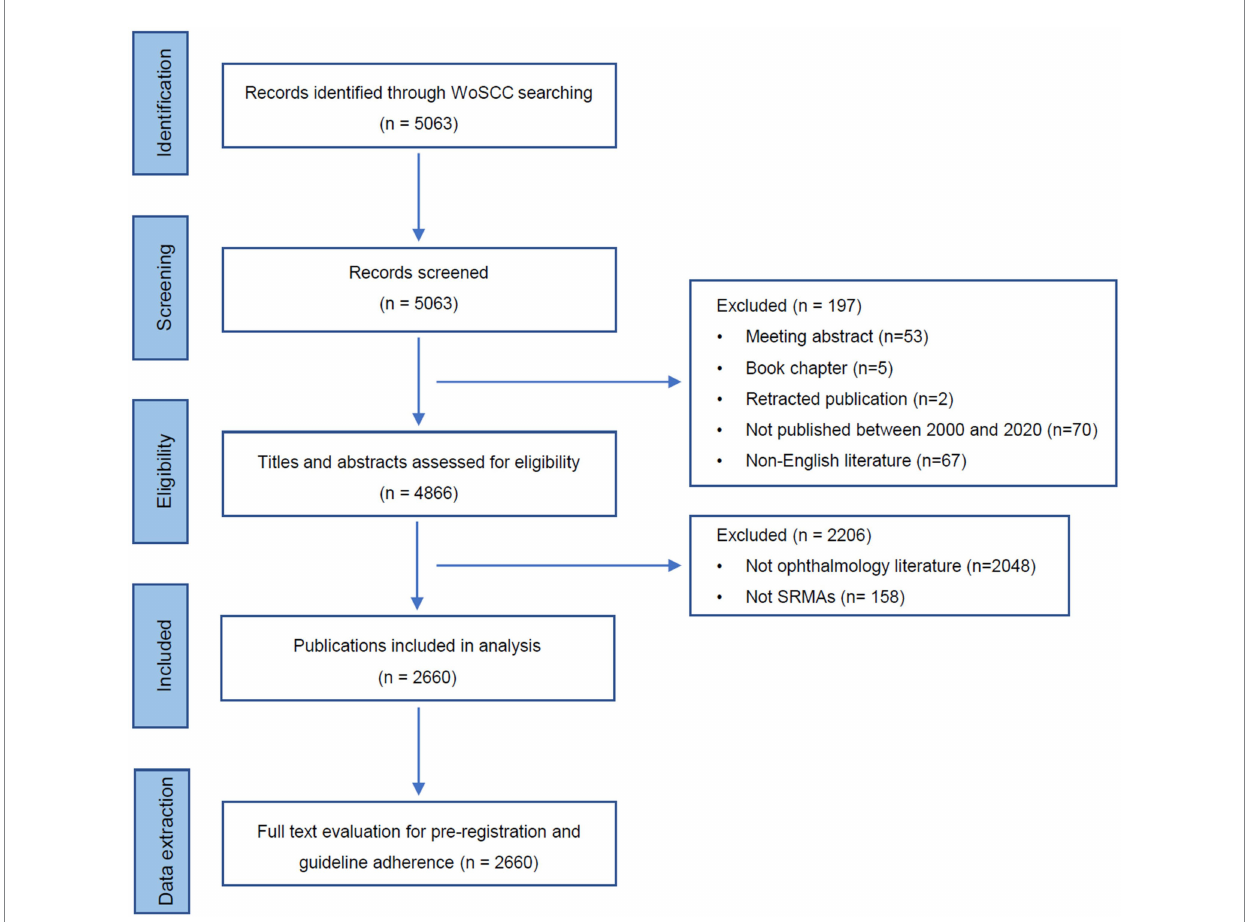
FIGURE 1 Flow diagram demonstrates the screening process of systematic reviews and meta-analyses in